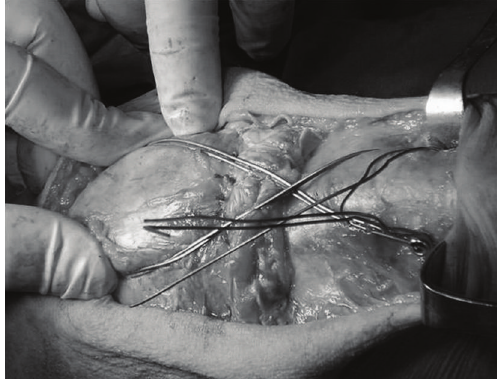
Figure 2: MRI of the left knee reveals complete rupture of the patellar tendon and patella alta.